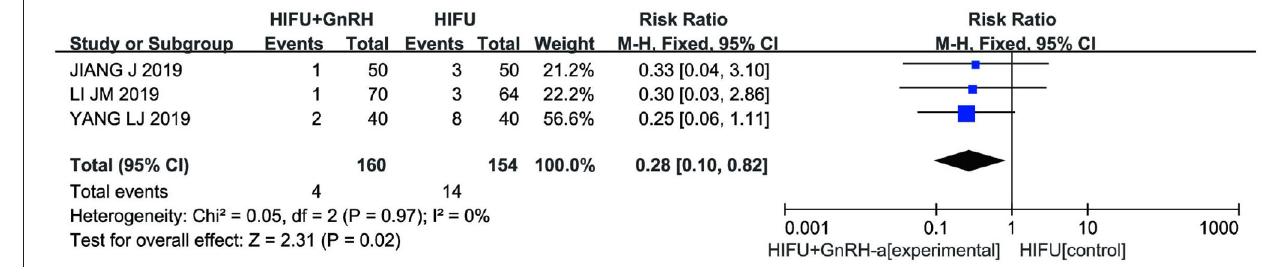
FIGURE 10 | Meta-analysis of recurrence rate in two groups.